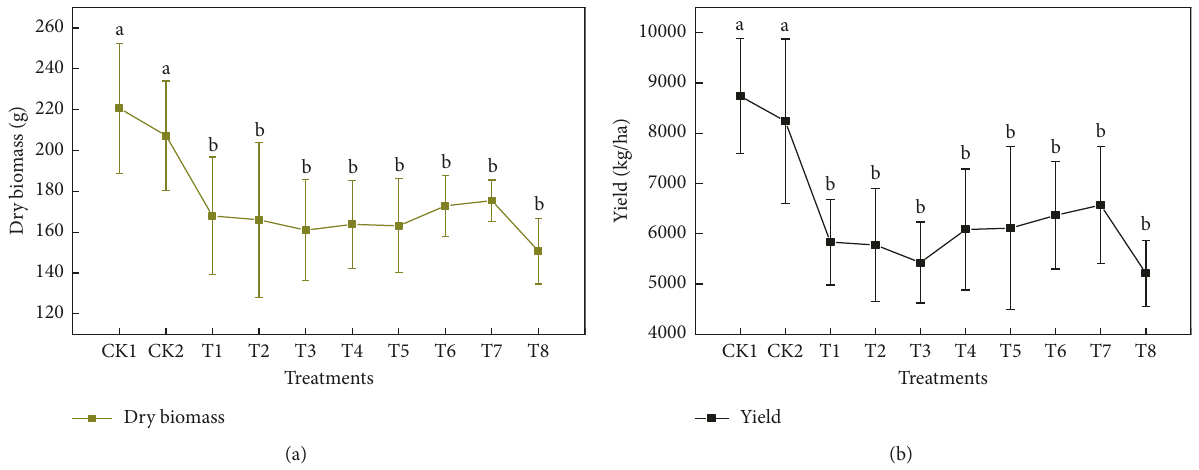
Figure 6: Dry biomass and corn yield of different treatments at mature